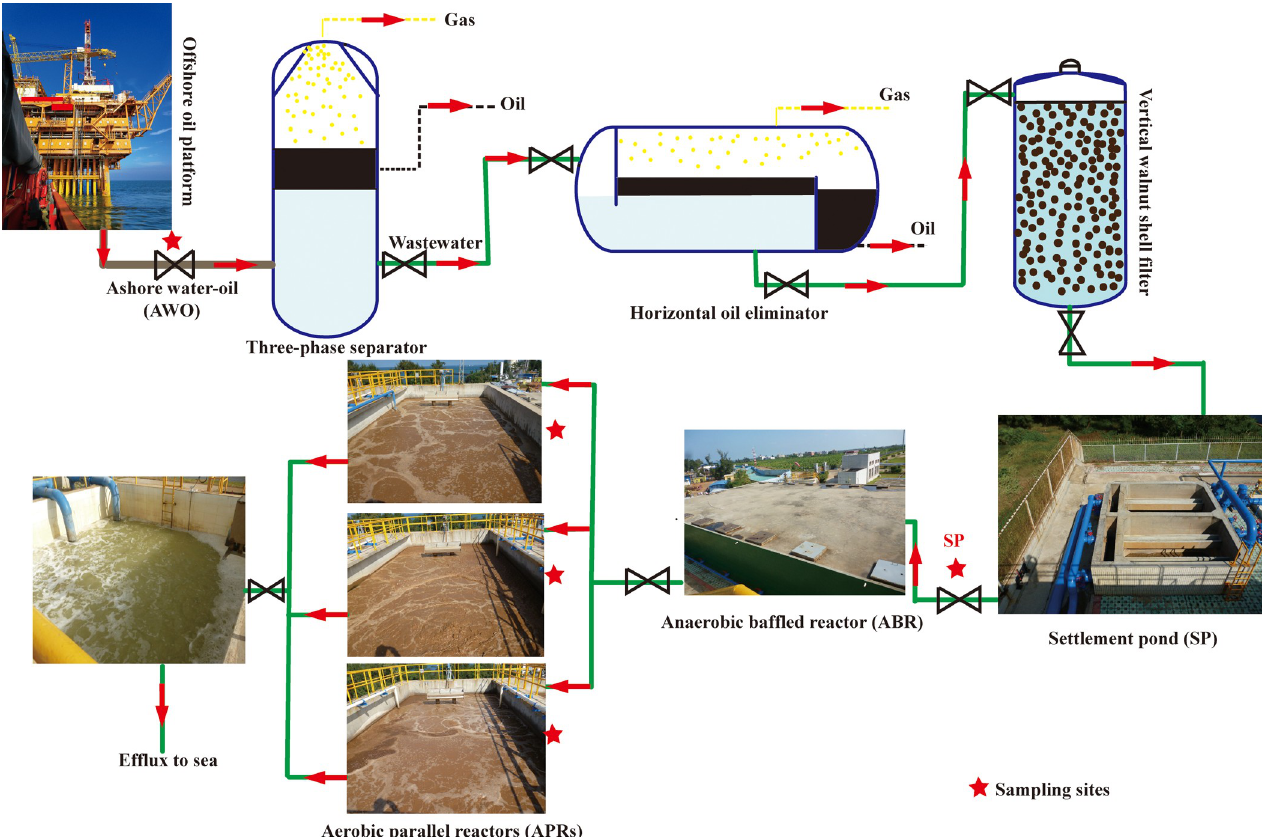
Fig 1. A schematic overview of the full-scale offshore produced water treatment plant, red stars showing the sampling sites.